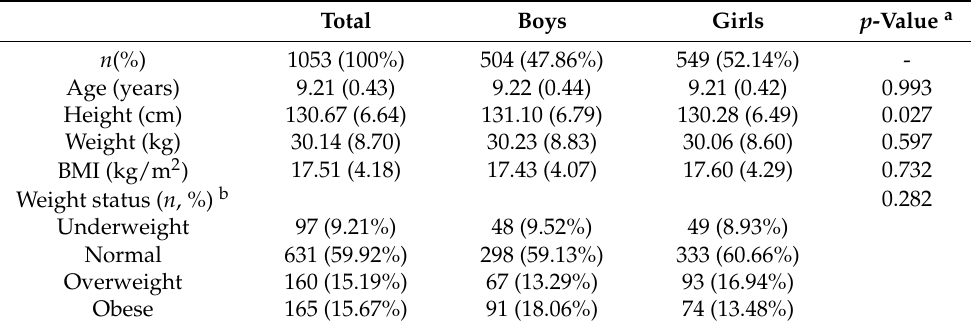
Table 1. Descriptive statistics of children’s characteristics. Total Boys Girls p -Value